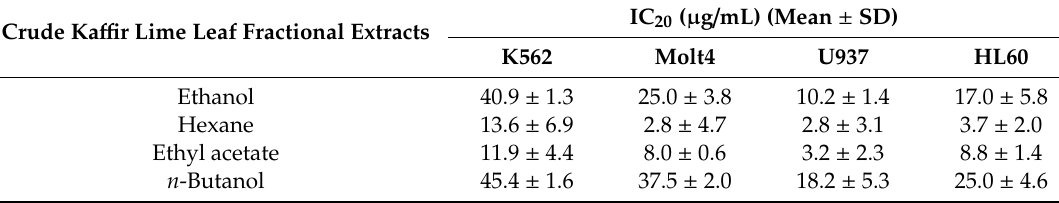
Table 1. IC 20 values of crude ka ffi r lime leaf fractional extracts determined from plot of percent cytotoxicity on K562, Molt4, U937, and HL60 cell lines. Crude Ka ffi r Lime Leaf Fractional